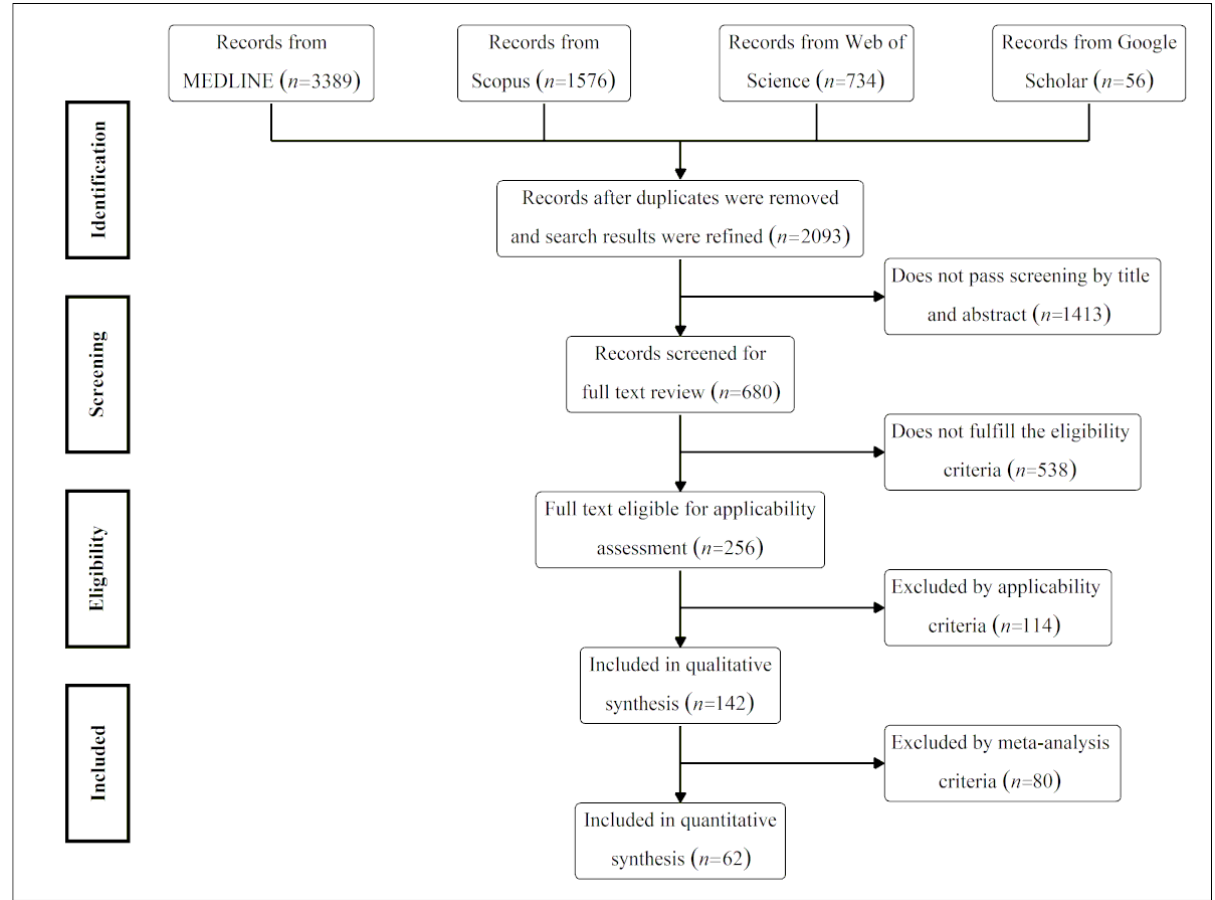
Figure 1. Study selection